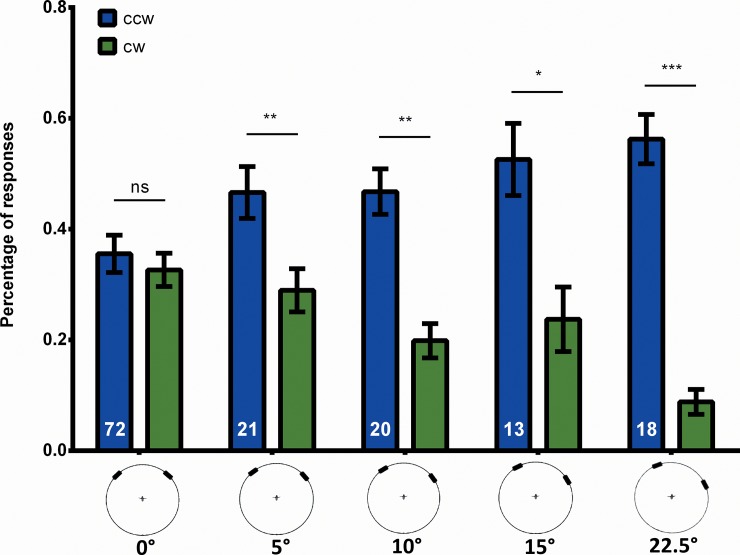
Effects of externally caused sidedness on response frequency.When two stripes are simultaneously displaced at ψ0 = ±45°, flies respond to either stripe equally often. If the longitudinal axis of the fly is slightly shifted with respect to the stripes, the fly favours the stripe that is more in front. Error bars are SEMs (*P < 0.05, **P < 0.01, ***P < 0.001).